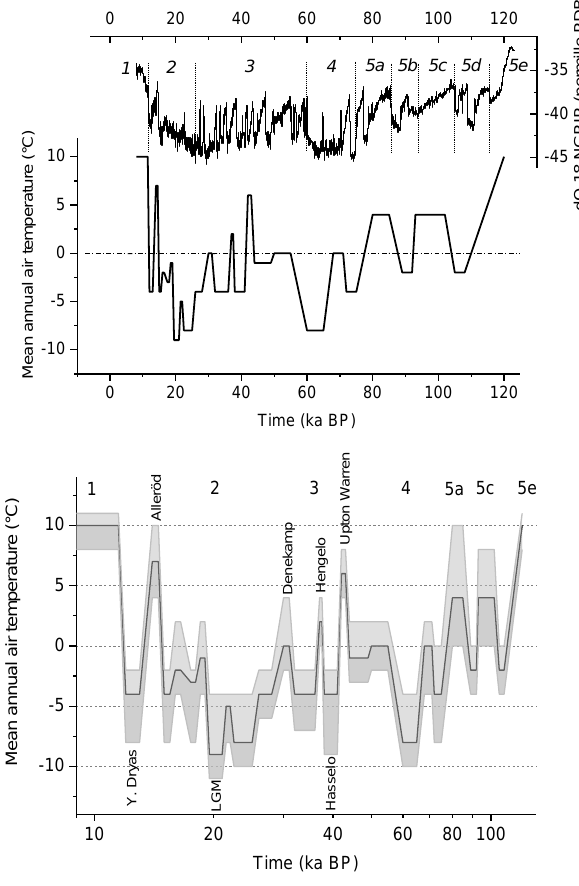
Figure 3. Top: best estimate temperature evolution for the We- ichselian glaciation, which is taken as an analogue for a future glacial climate in permafrost calculations. The curve is based on data from van Gijssel (1995), Huijzer and Vandenberghe (1998), Renssen and Vandenberghe (2003), Busschers et al. (2007) and Buylaert et al. (2008). Marine isotope stages (numbering 1 to 5e) are taken from Busschers et al. (2007) and references therein. The oxygen isotope curve is reproduced from the North Green- land Ice Core Project (NGRIP) (2004) data. Bottom: upper and lower bound values for stochastic permafrost calculations on a log- arithmic timescale. MIS5e is equivalent to the Eemian interglacial, while MIS1 corresponds to the Holocene (present interglacial). Y. Dryas = Younger